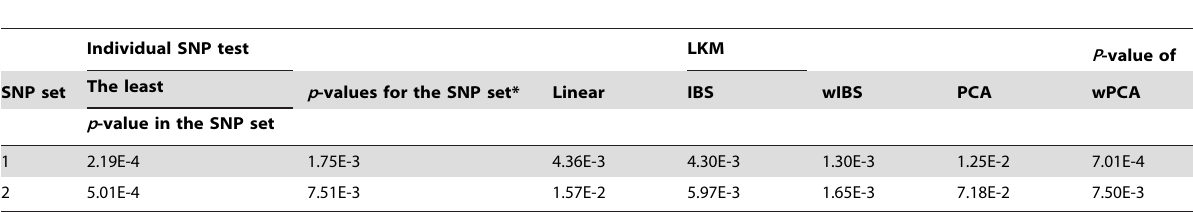
Table 5. Results of LKM, PCA and wPCA on the Analysis of a SNP set from a real GWAS dataset.